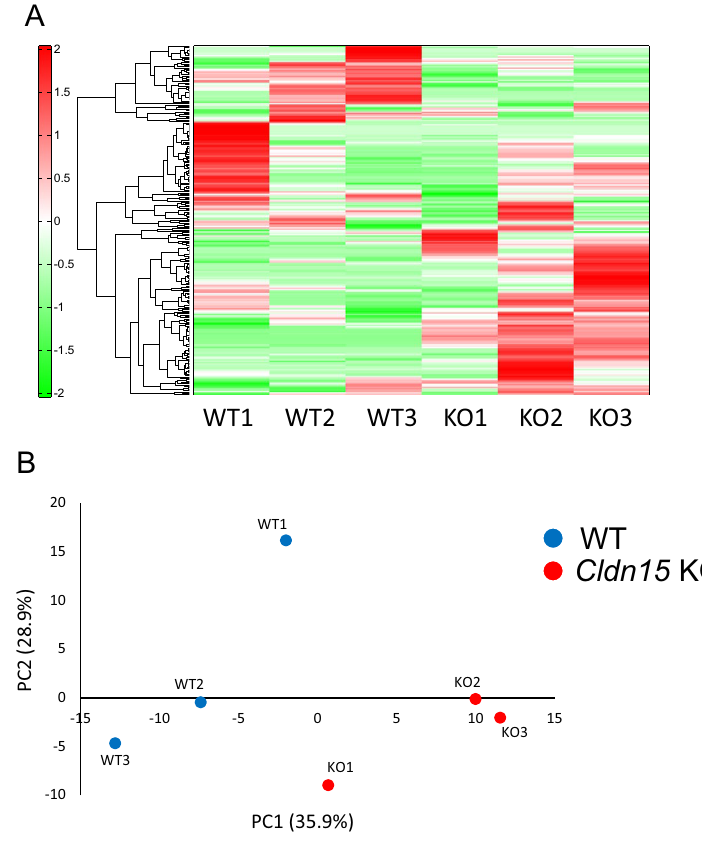
Figure 2. Metabolomic analysis of cecal contents. The contents of the cecum were collected from Cldn15 KO and WT mice. The contents were weighed and then the water-soluble metabolites were extracted and analyzed by CE-TOFMS. ( A ) Hierarchical clustering heat map showing the patterns of intestinal metabolite between the samples. Green and red show lower and higher concentrations respectively. Heatmap was created by Human Metabolome Technologies, Inc. (HMT) using proprietary software developed in-house. ( B ) Principal component analysis of the metabolome data from the cecal luminal contents from Cldn15 KO (red dots) and WT (blue dots)